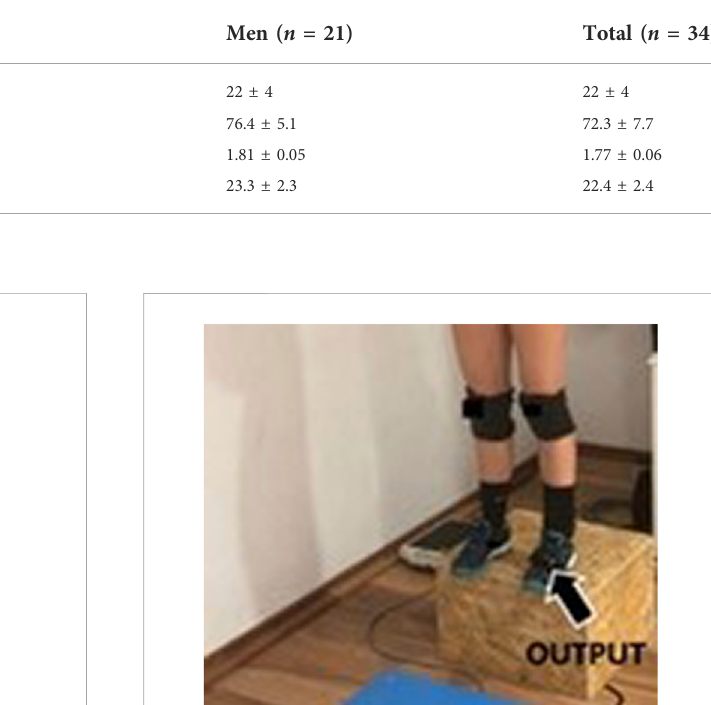
TABLE 1 Anthropometric characteristics of the subjects.